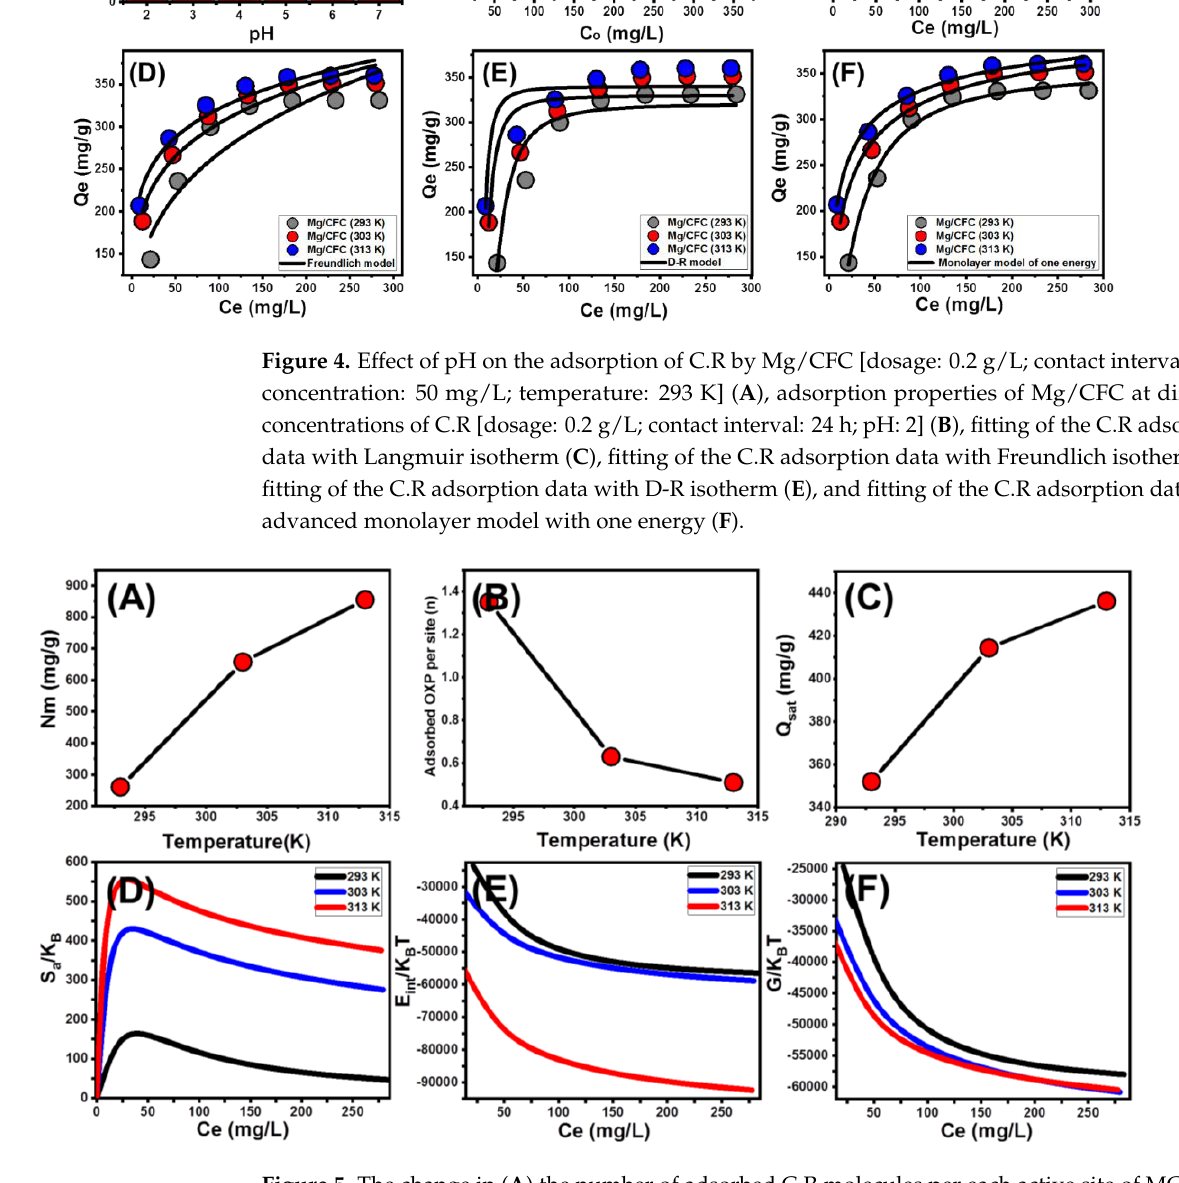
Figure 5. The change in ( A ) the number of adsorbed C.R molecules per each active site of MG/CFC, ( B ) the occupied active sites density by C.R molecules, ( C ) the entropy properties of the C.R adsorption reactions by MG/CFC, ( D ) internal energy of the C.R adsorption reactions by MG/CFC ( E ), and enthalpy of the C.R adsorption reactions by MG/CFC ( F ).